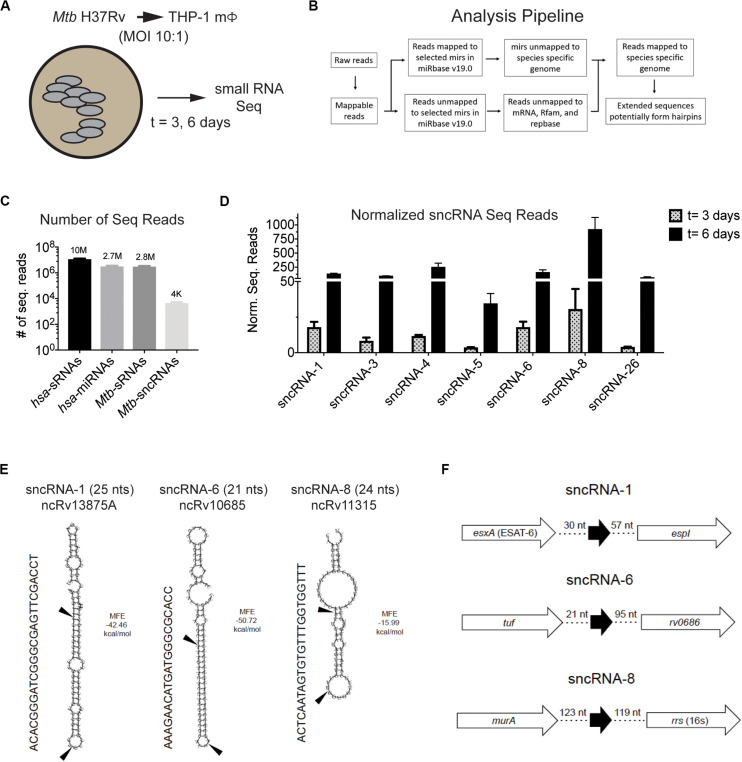
Mtb H37Rv produces many smaller noncoding RNAs during intracellular infections in macrophages. (A,B) Strategy to identify sncRNAs in Mtb is shown. (A) THP-1 macrophages were infected with Mtb H37Rv (10:1) for 3 h and RNA was isolated from THP-1 infected for 3 and 6 days. (B) RNA Seq was applied to sRNAs using the given algorithm. (C) The normalized read counts of sRNAs and miRNAs that mapped to the eukaryotic and mycobacterial genome are indicated. The Mtb-encoded sRNAs that resembled miRNAs were designated as sncRNAs. (D) The normalized sequence reads for the seven most abundant sncRNAs were determined at 3- and 6-days post-infection. Mean ± SD were determined from triplicate samples/time point, with p-values ranging from 6 × 10–3 to 1 × 10–10. (E) Secondary structure of sncRNA-1, sncRNA-6, and sncRNA-8 precursors predicted with RNAfold are shown. MFE < 0 indicates stable RNA structure. The mature forms of the sncRNAs are indicated with arrows. Other designation of these sncRNAs are shown below the titles. (F) Genomic positions of sncRNA-1, sncRNA-6, and sncRNA-8 are shown.